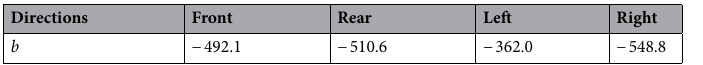
Table 1. The data of slopes of the sigmoidal function ( b ) in each direction.